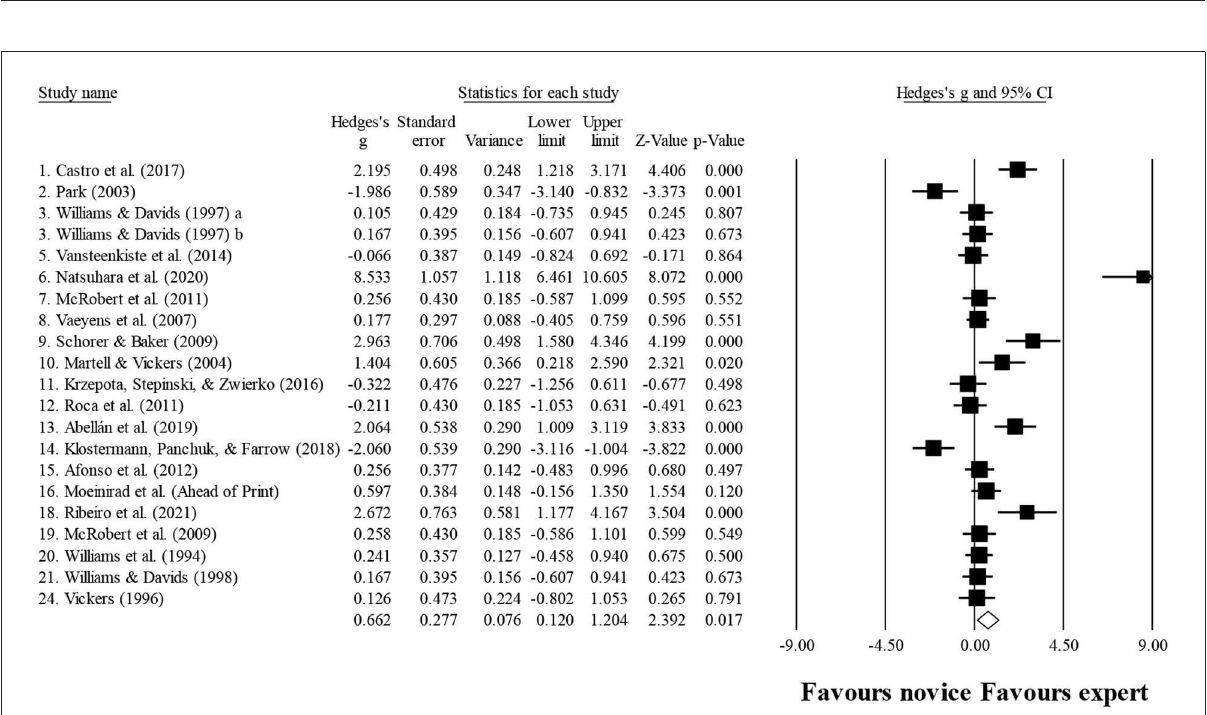
FIGURE2 Chronological age: greater chronological age was noted for expert athletes compared to novice athletes. Black squares: individual studies. Its size represents their relative weights. White rhomboid: summary